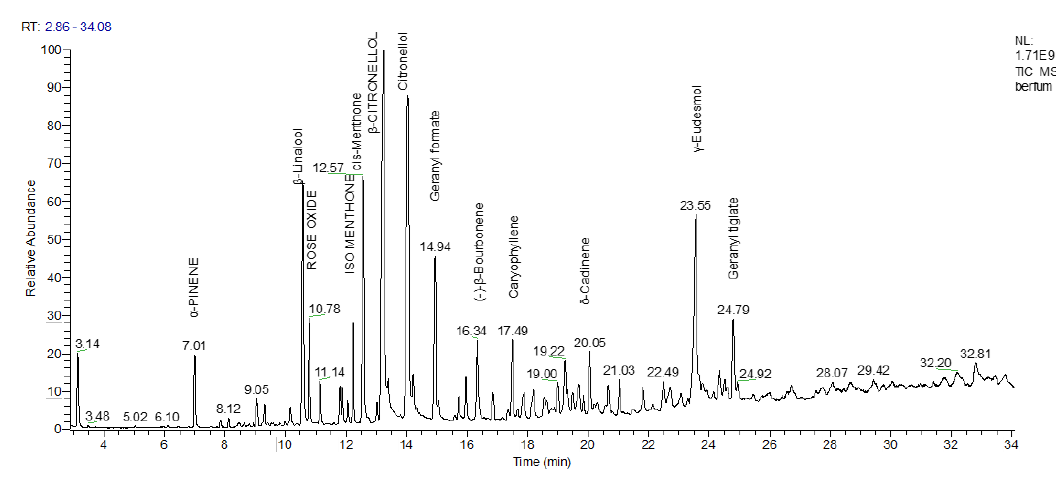
Figure 1. Total ion chromatogram of P. graveolens essential oil using GC–MS.